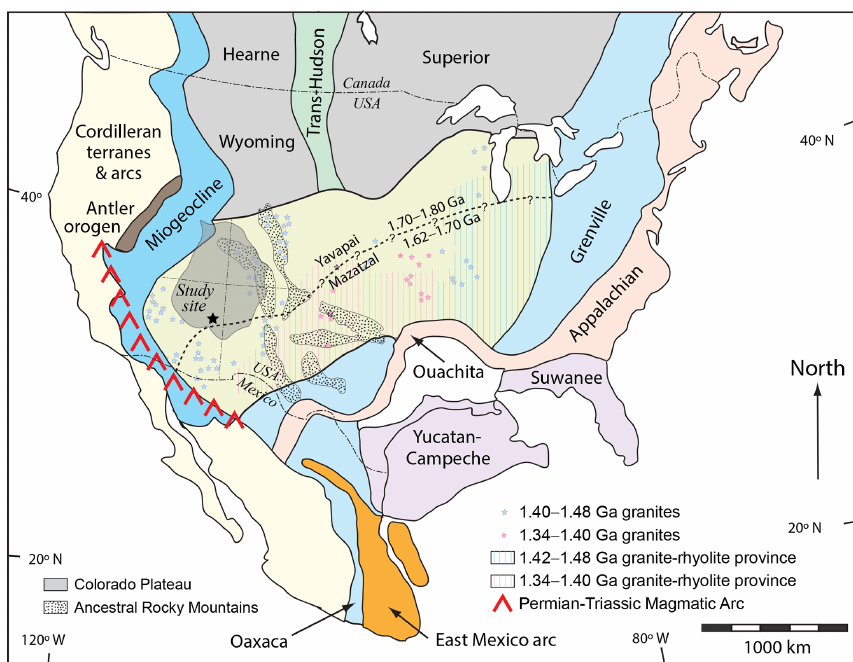
Figure 1. Map showing the main basement provinces of southern North America and Mexico. Also shown are locations of the study area within the Colorado Plateau, outlines of Ancestral Rocky Mountain uplifts, and the Permian–Triassic magmatic arc along the continental margin of southwestern North America. Modified from Gehrels et al.